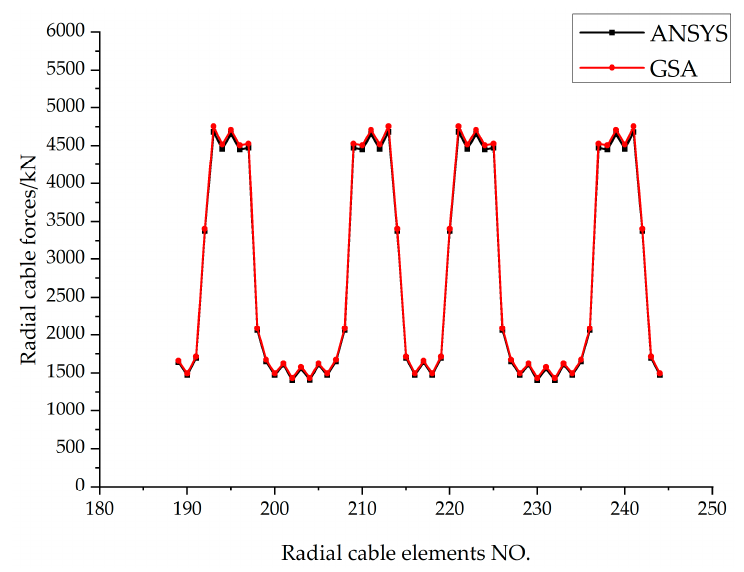
Figure 13. Comparison curve of radial cable force (kN).